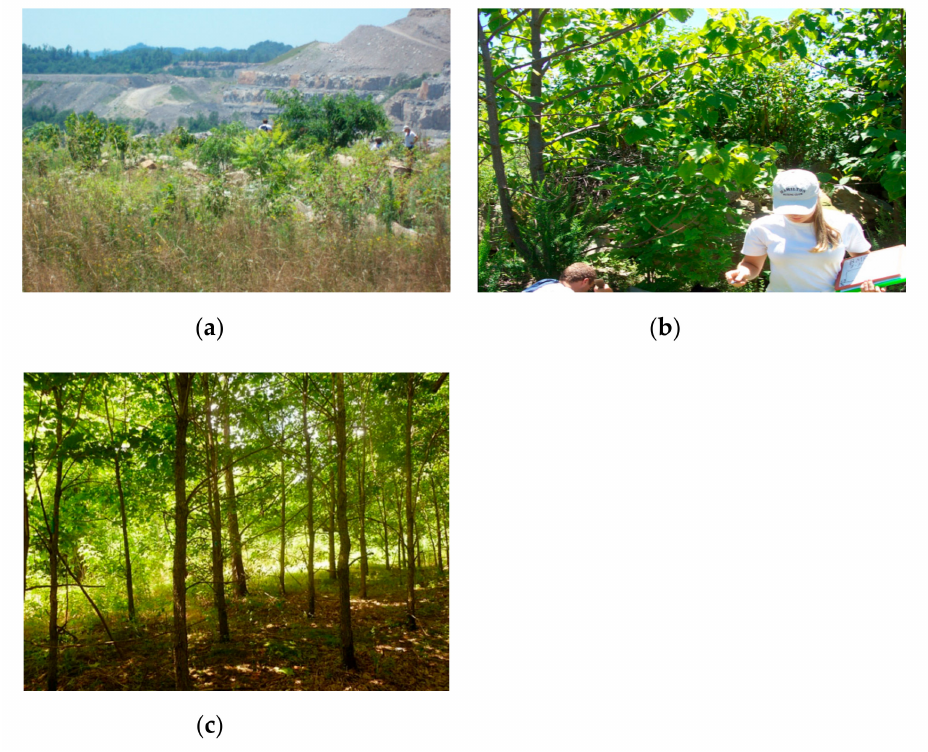
Figure 3. Field views of chronosequence of reclaimed mineland sites at 2 years ( a ), 5 years ( b ), and 13 years ( c ) after